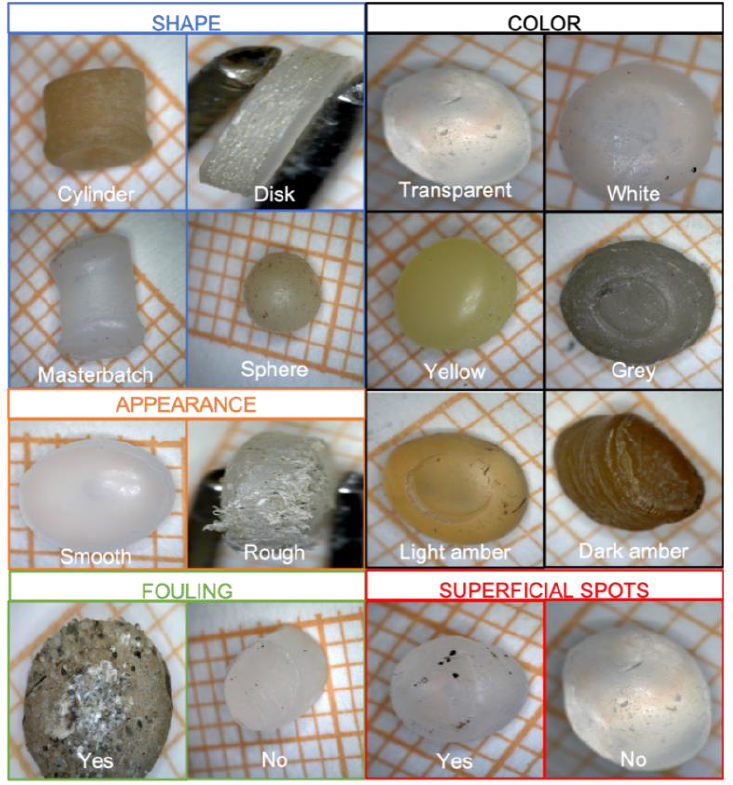
Figure 2. Different kinds of pellets. Masterbatch pellets are used in plastic manufacturing to carry pigments or other additives.